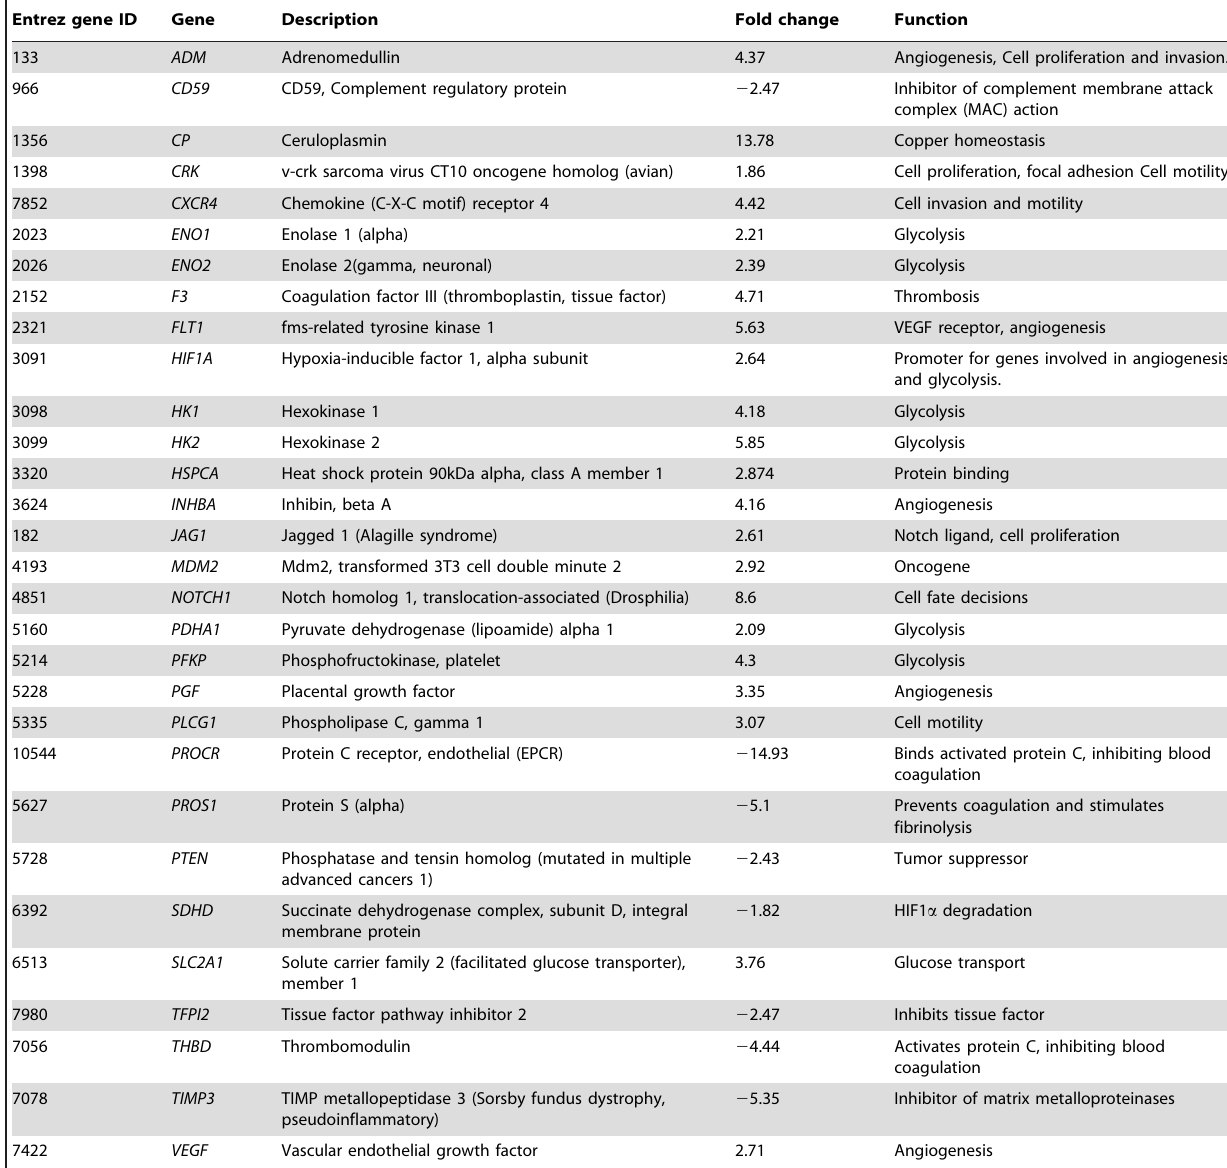
Differentially expressed genes identified in the clear cell microarray involved in coagulation, angiogenesis, cell proliferation, cell motility, and glucose metabolism (average fold change $ 1.5; P , 0.001). doi:10.1371/journal.pone.0021121.t002 (Figure 3b). The degree of knockdown efficiency of ENO1 correlated with the amount of growth inhibition; while RMG1 demonstrated growth inhibition with knockdown of ENO1, it was the least efficient of the three clear cell cell lines and this amount of growth inhibition was not statistically significant (p = 0.12). Serous ovarian cancer cell lines OVCA420 and OVCA429 were growth inhibited in hypoxia (1% O2) and glucose deprivation (HG) conditions and the transfection with siRNA targeting HIF1 a and ENO1 has limited effect on further growth inhibition compared to the control transfected cells (Figure 3c and d). Further the Knockdown of HIF1 a and Enolase 1 was performed on clear cell cell lines ES-2 and PLoS ONE |